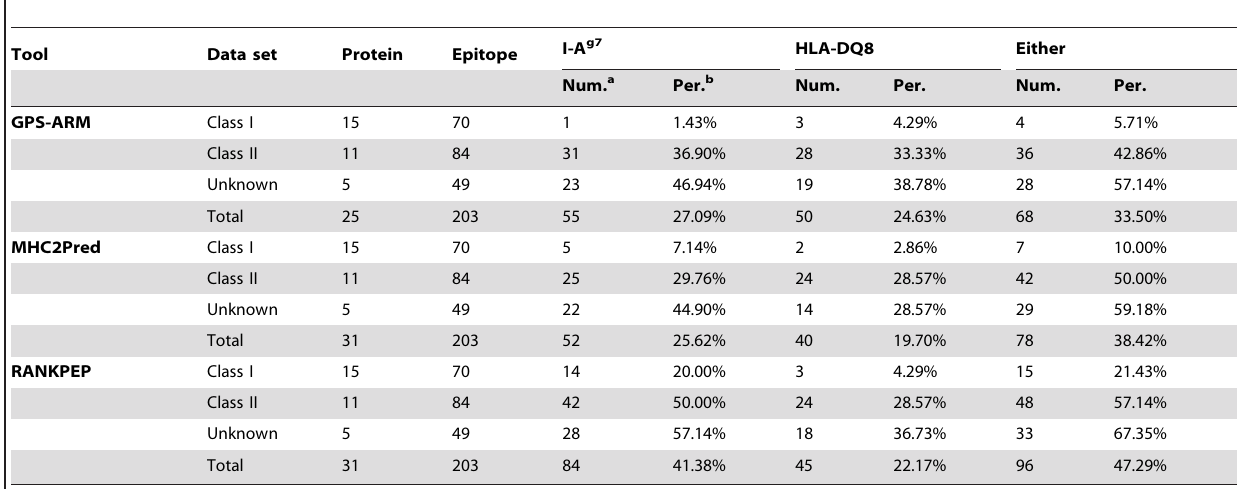
Table 3. The statistical data for the prediction of potentially new I-A g7 and HLA-DQ8 epitopes in T1D.